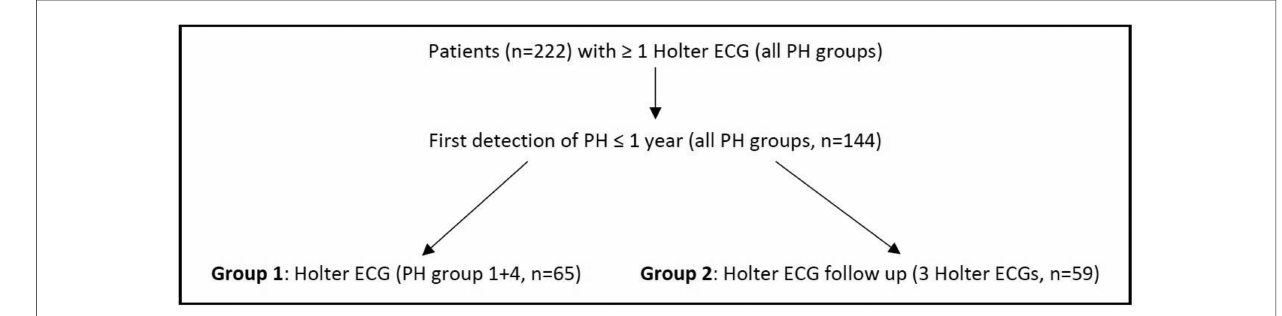
FIGURE 1 Description of the study population. ECG=electrocardiogram; PH=pulmonary